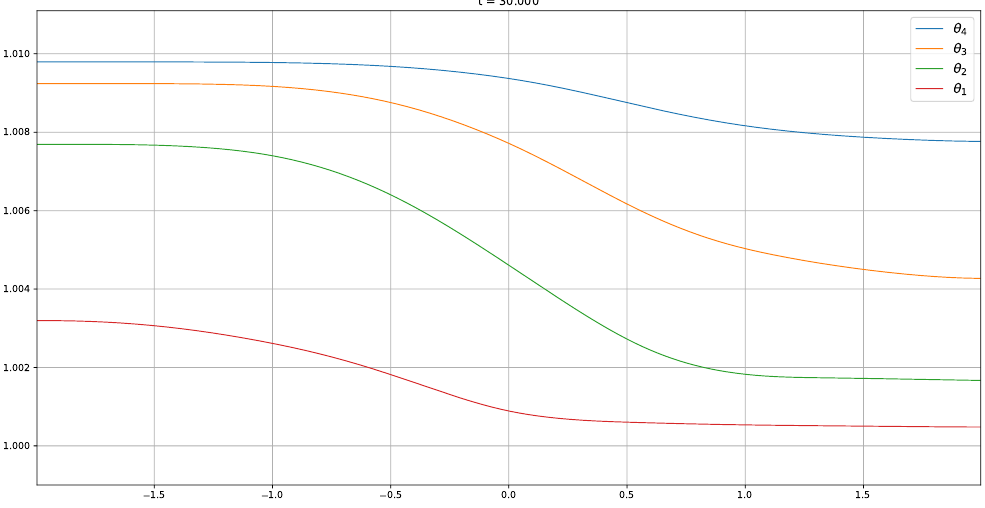
Figure 5. Simulation with M = 4 number of layers for a version of the code with an upwind approximation. The relative density θ α is